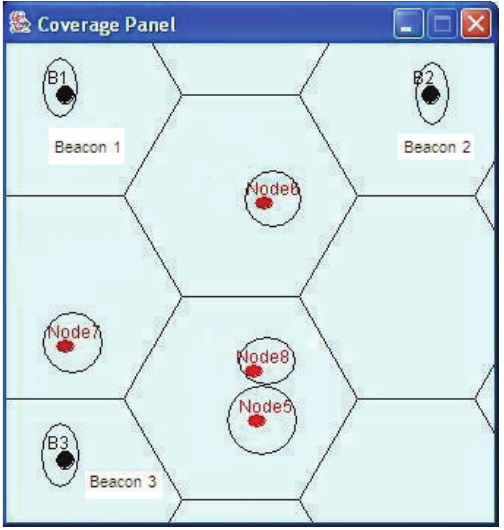
Figure 19: Final location of nodes.